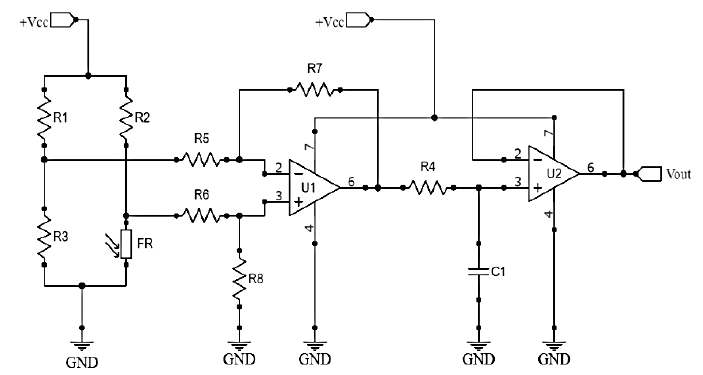
Figure 3. Conditioning circuit for the photoresistor sensors.